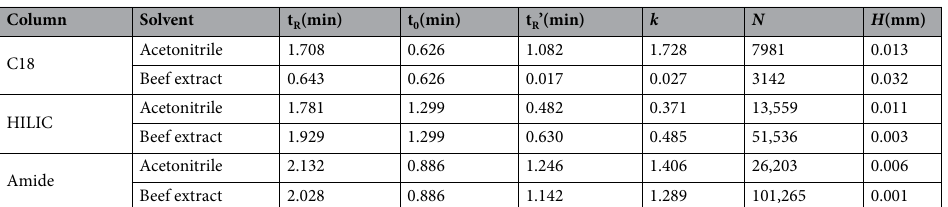
Table 1. HPLC chromatographic characteristics of nereistoxin in a mobile phase consisting of water/ acetonitrile (10:90, v/v) with 0.1% formic acid. t R –retention time; t 0 –dead time; t R ’–adjusted retention time; k –capacity factor; N –number of theoretical plates; H –height of theoretical